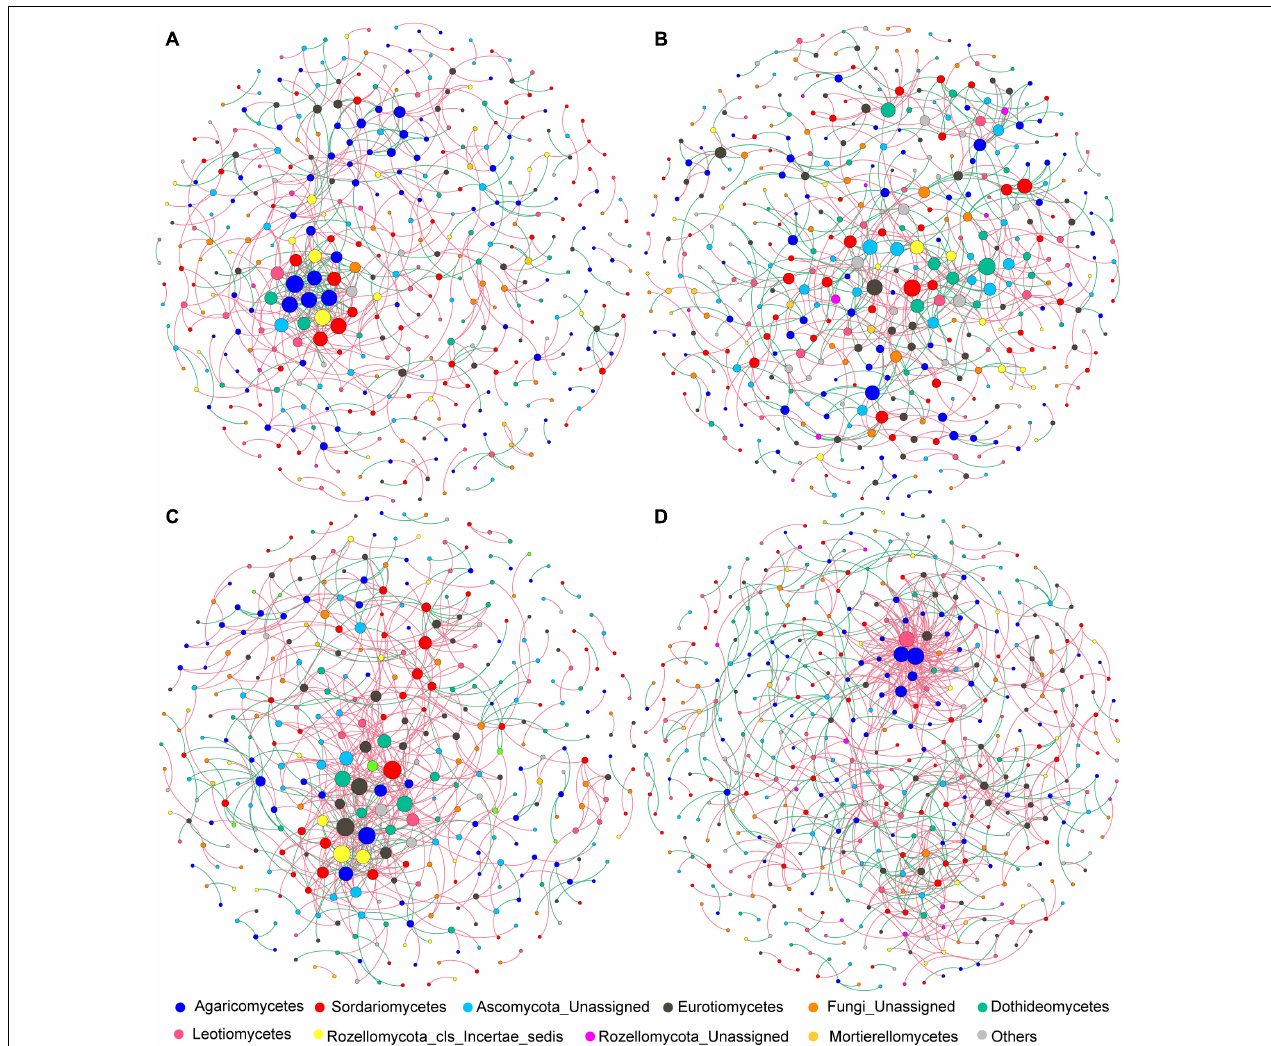
FIGURE 6 | (A–D) Co-association patterns of OTUs of fungal community in control and N addition treatments at the short- and long-term sites, respectively. The size of each node is proportional to the number of connections (i.e., degree). The red and green edges indicate positive and negative associations between two individual nodes,